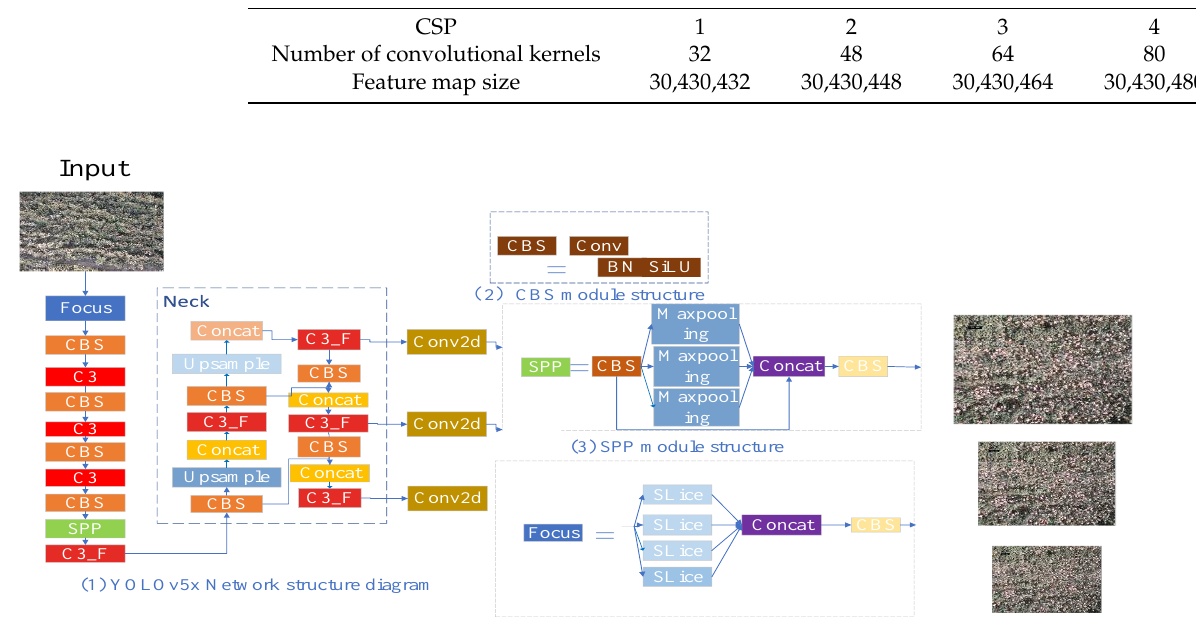
Figure 5. YOLOv5x network structure diagram.